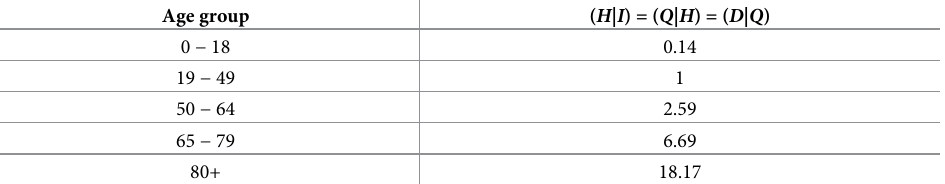
Table 2. The estimated conditional relative risk (RR) for each age group relative to the reference age group of 19– 49. The estimated conditional RR of advancing to the next stage of illness is equivalent across the three models, ( H | I ), ( Q | H ), and ( D | Q ). The RR are conditional to the other risk factors and estimated from LAC infection and death data stratified by age, using the combination of the epidemic and risk